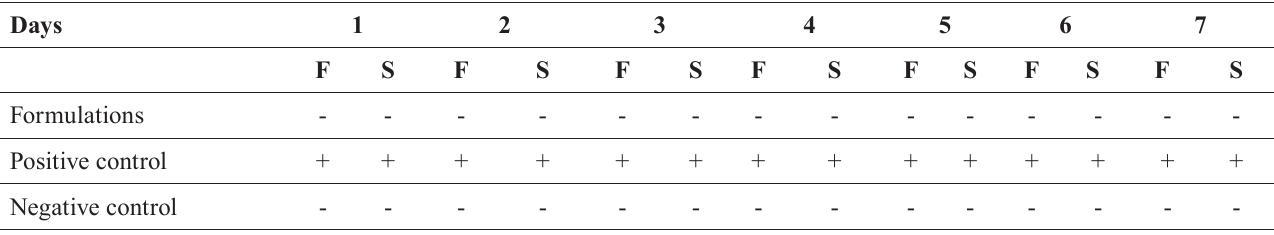
TABLE IV - Test for sterility in fluid thioglycolate medium (F) and soyabean casein digest medium (S) Days